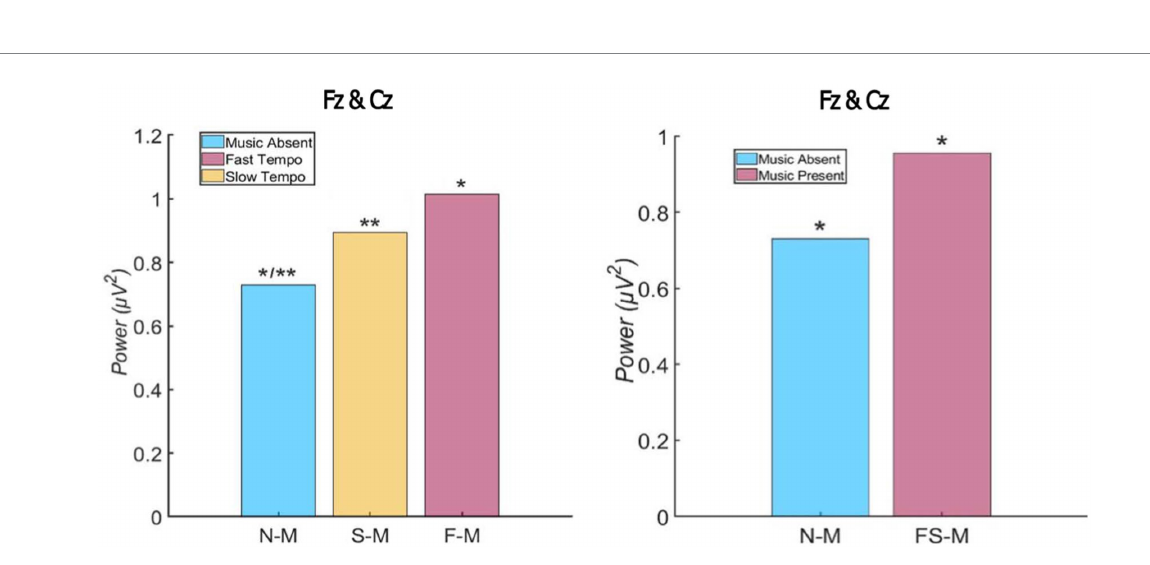
levels of the three conditions [ F (2,40) = 11.500, p = 0.000,